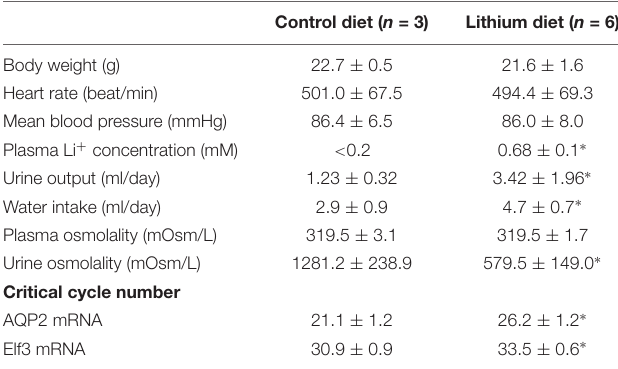
TABLE 2 | Physiological measurements in mice on control or lithium diet for 2